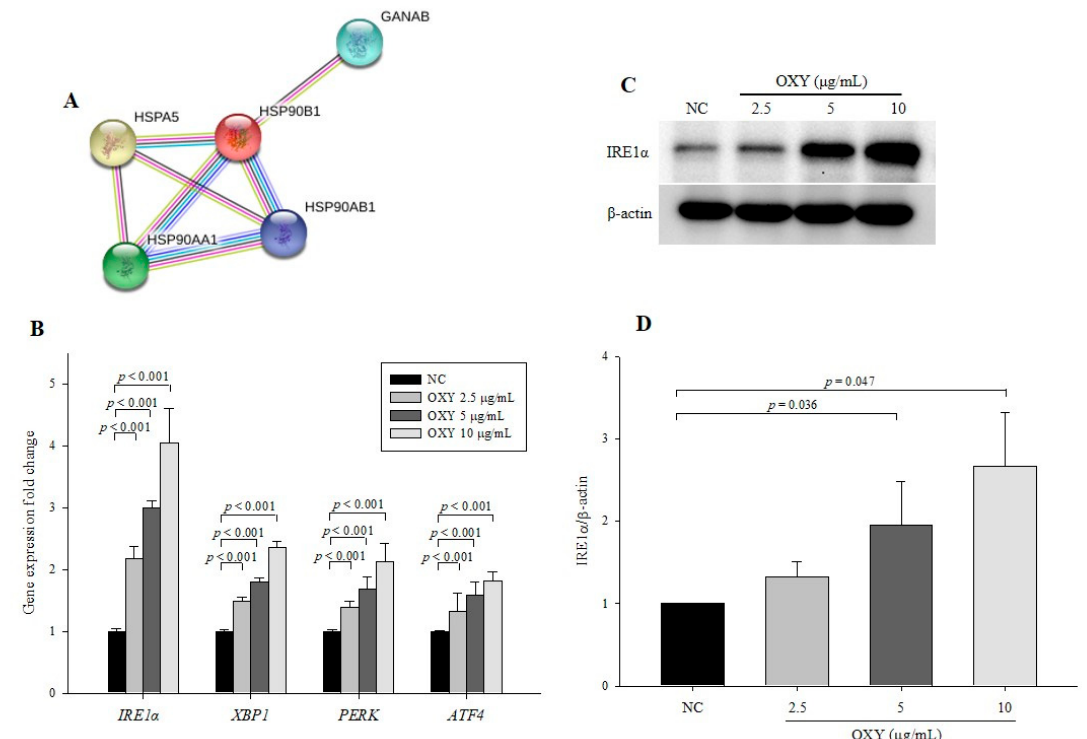
Figure 7. Effect of OXY on the expression levels of endoplasmic reticulum (ER) stress signaling pathway-related genes and proteins. Protein–protein interaction images were displayed using STRING ( A ). Expression levels of IRE1 α , XBP1 , PERK , and ATF4 were determined by qPCR ( B ). The expression level of the IRE1 α protein was measured by Western blotting ( C ) and quantified ( D ). From each lysate, equal amounts of protein were loaded on a separate gel, blotted for actin, and this signal was used for determining the ratio of the protein of interest / actin as displayed in the figure. The cropped blots are representative of three independent experiments. The full-length blots are shown in Supplementary Figure S5. Each value indicates the mean ± SD of three independent experiments performed.